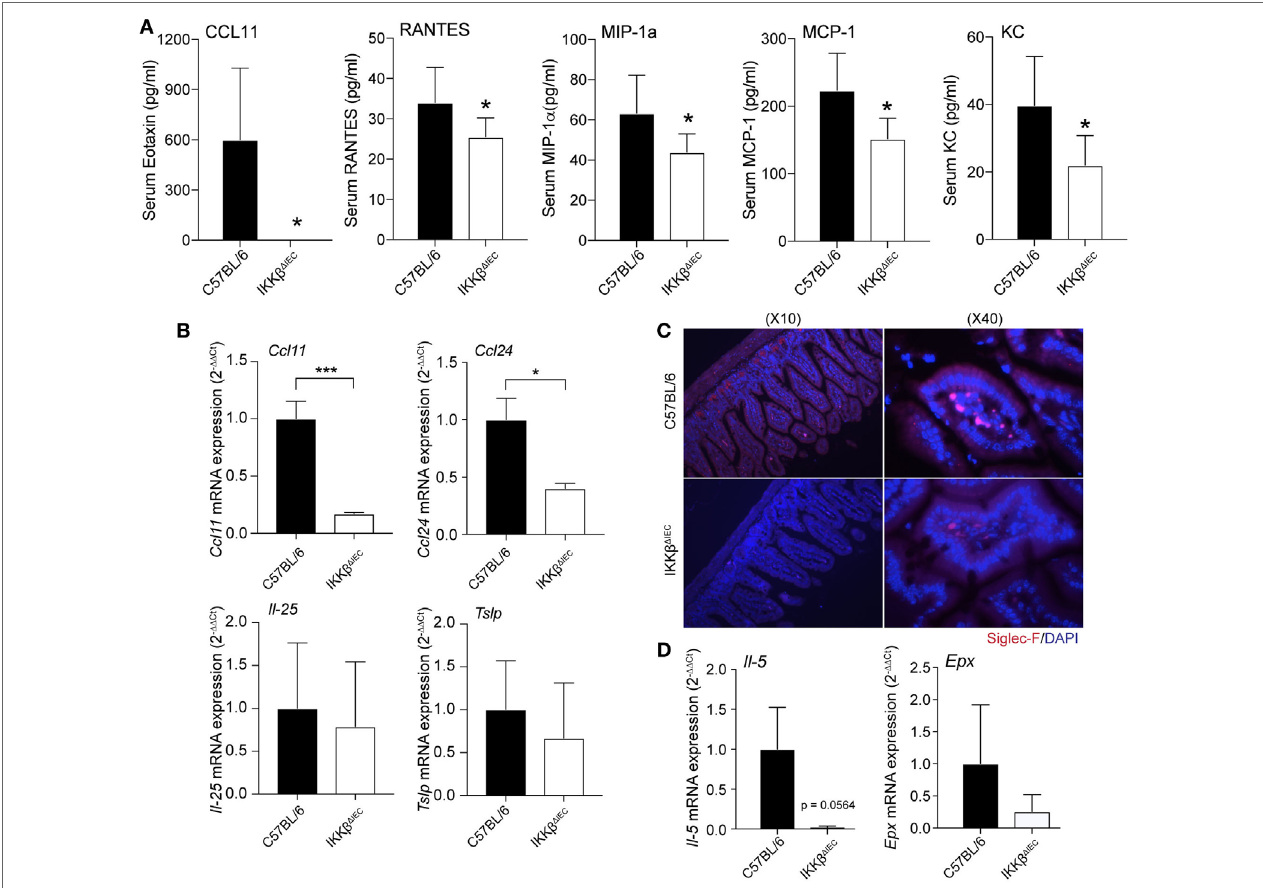
FigUre 3 | Serum chemokines and gut eosinophil levels in IKK β Δ IEC mice following oral sensitization and oral allergen challenge. (a) Serum chemokines. Serum samples were collected 2 h after allergen challenge on day 30 and the concentrations of chemokines were evaluated by multiplex assay. Data are expressed as mean ± SD. * p < 0.05; ** p < 0.01 and are from at least five experiments and five mice/group. (B–D) Analysis of small intestinal tissues collected on day 30 and 2 h after allergen challenge of wild-type and IKK β Δ IEC mice. (B) Eotaxin-1 ( Ccl11), eotaxin-3 (Ccl24 ), il-25, and Tslp mRNA levels. (c) Eosinophils in small intestine. Thin sections of small intestinal tissues were stained with an anti-Siglec-F antibody and counterstained with DAPI to visualize nuclei. (D) Il-5 and eosinophil peroxide ( Epx ) mRNA levels. The mRNA data are expressed as mean ± SD. * p < 0.05; ** p < 0.01, and are from at least five experiments and five